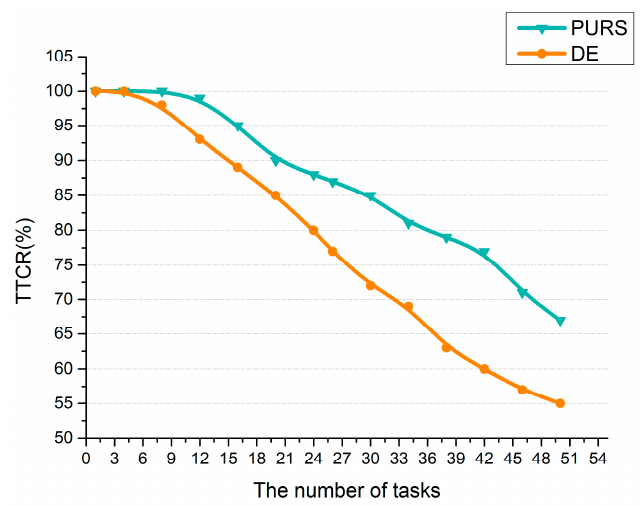
Figure 4. The task time completion rate (TTCR) of two algorithms.